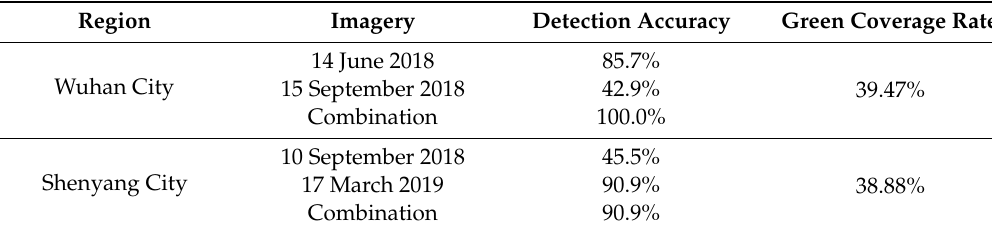
Table 7. Detection accuracy table of Shenyang’s